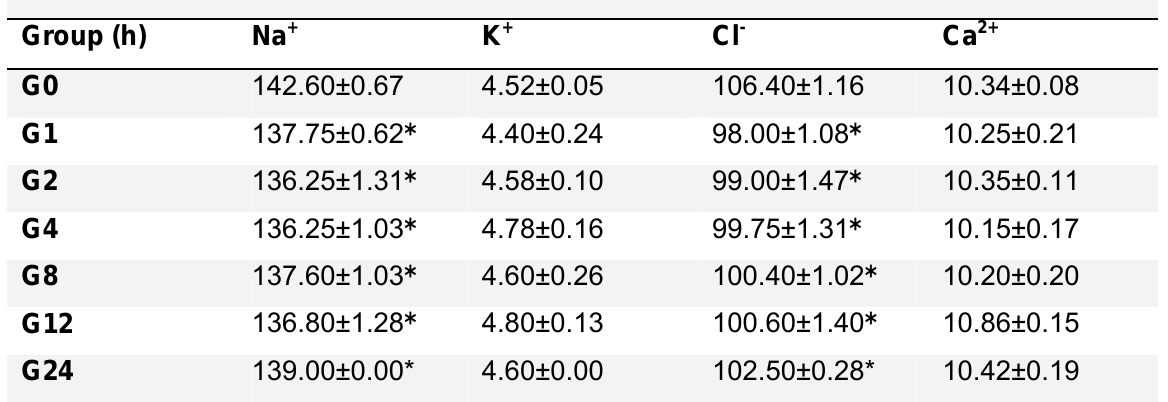
Table 5. Effects of a single sc injection of Androctonus crassicauda venom on the levels of serum sodium ( Na + ; mmol/l), potassium ( K + ; mmol/l), chlorine ( Cl - ; mmol/l), and calcium ( Ca 2+ ; mg/dl) ions in rats at the 1 st (G1), 2 nd (G2), 4 th (G4), 8 th (G8), 12 th (G12), and 24 th (G24) hours after venom injection. Results are presented as the mean±S.E.